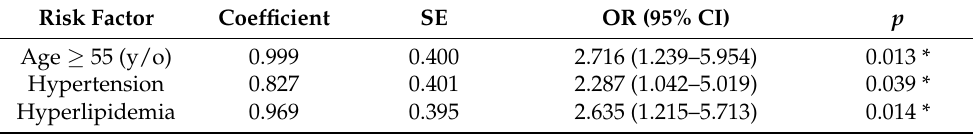
Table 3. Multivariate analysis of risk factors for significant coronary artery